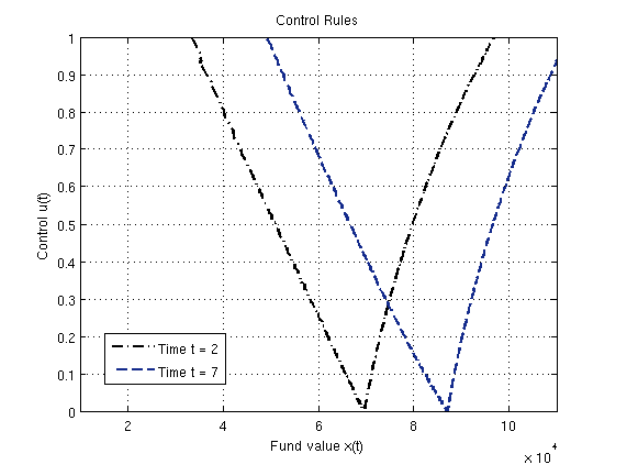
= $100 , 000 and t = 2 , t = 7 T